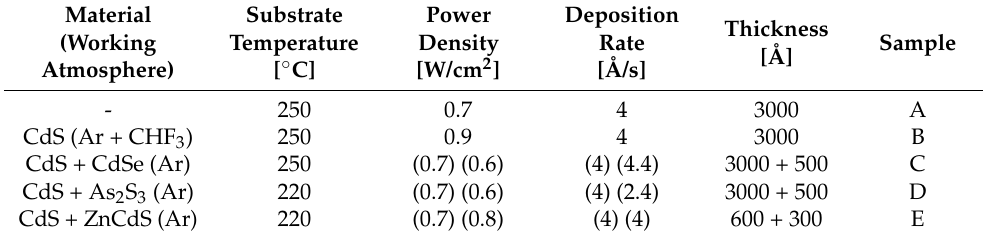
Table 1. The main sputtering parameters related to the deposition of the window